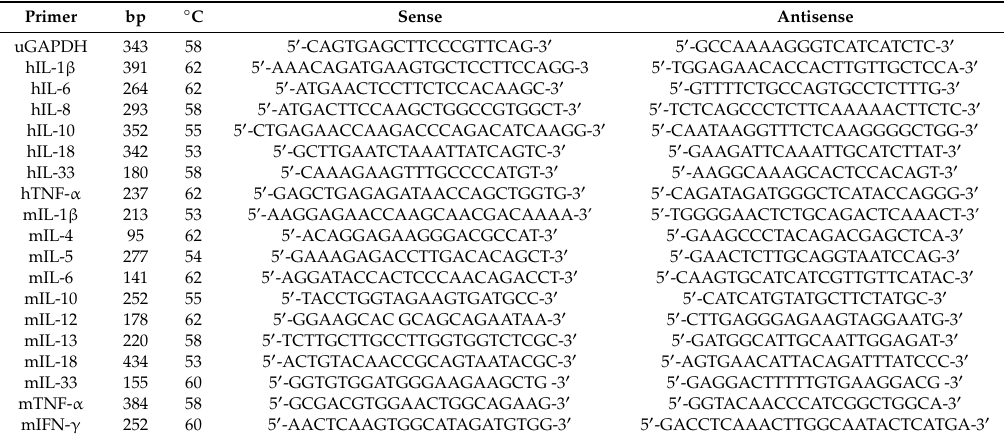
Table 3. Primer sequences used in